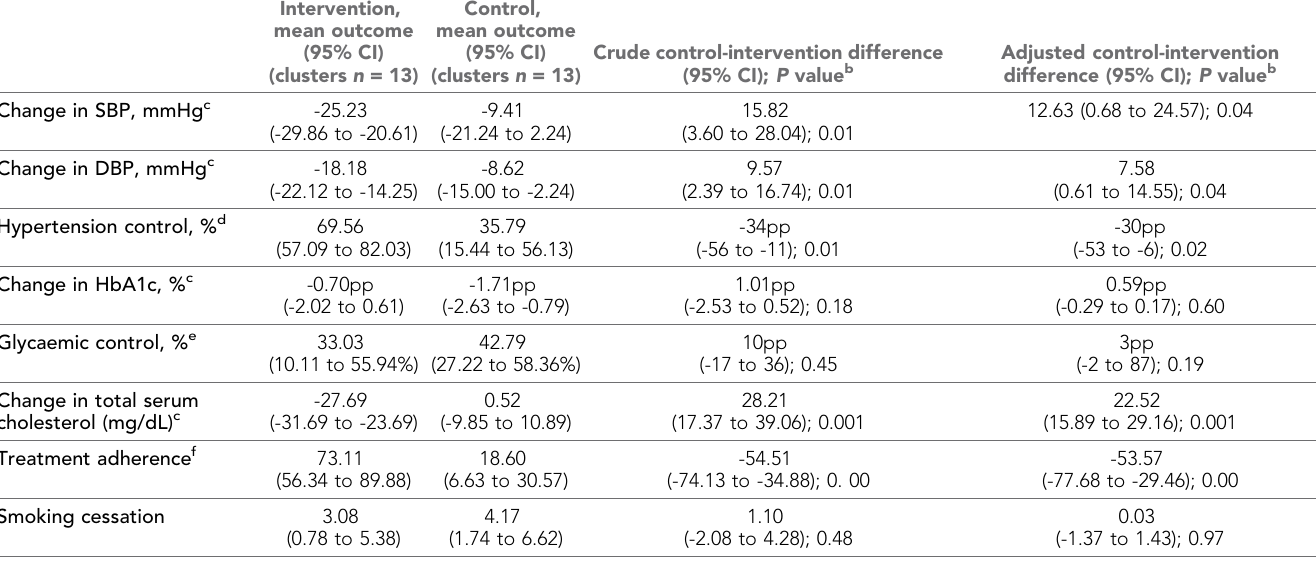
Table 2. Primary and secondary outcomes